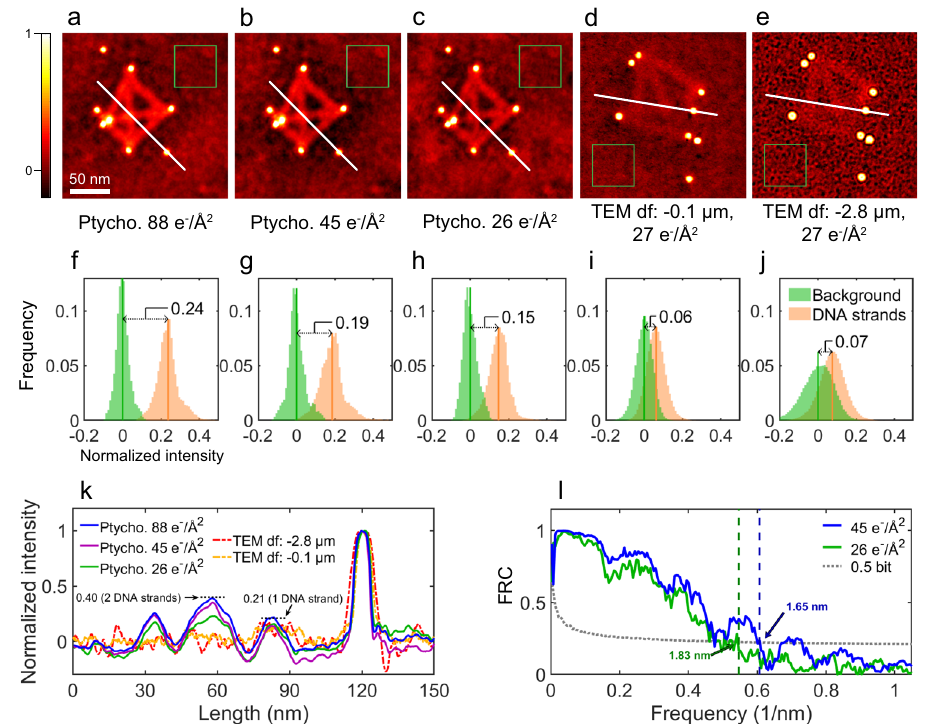
Fig.3|2DptychographicphasesanddefocusedTEMimages.a – c Normalised2D ptychographic phases with doses of 88, 45 and 26 e − /Å 2 , respectively. Recon- structed with independent randomly initialised phase guesses (as shown in Sup- plementary Fig. 9). d , e Normalised representative TEM images (from a set of typically 20 recorded) with doses of 27 e − /Å 2 and defoci of − 0.1 and − 2.8 μ m,